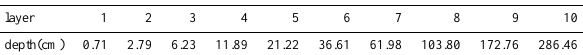
Table 5. The depth of each